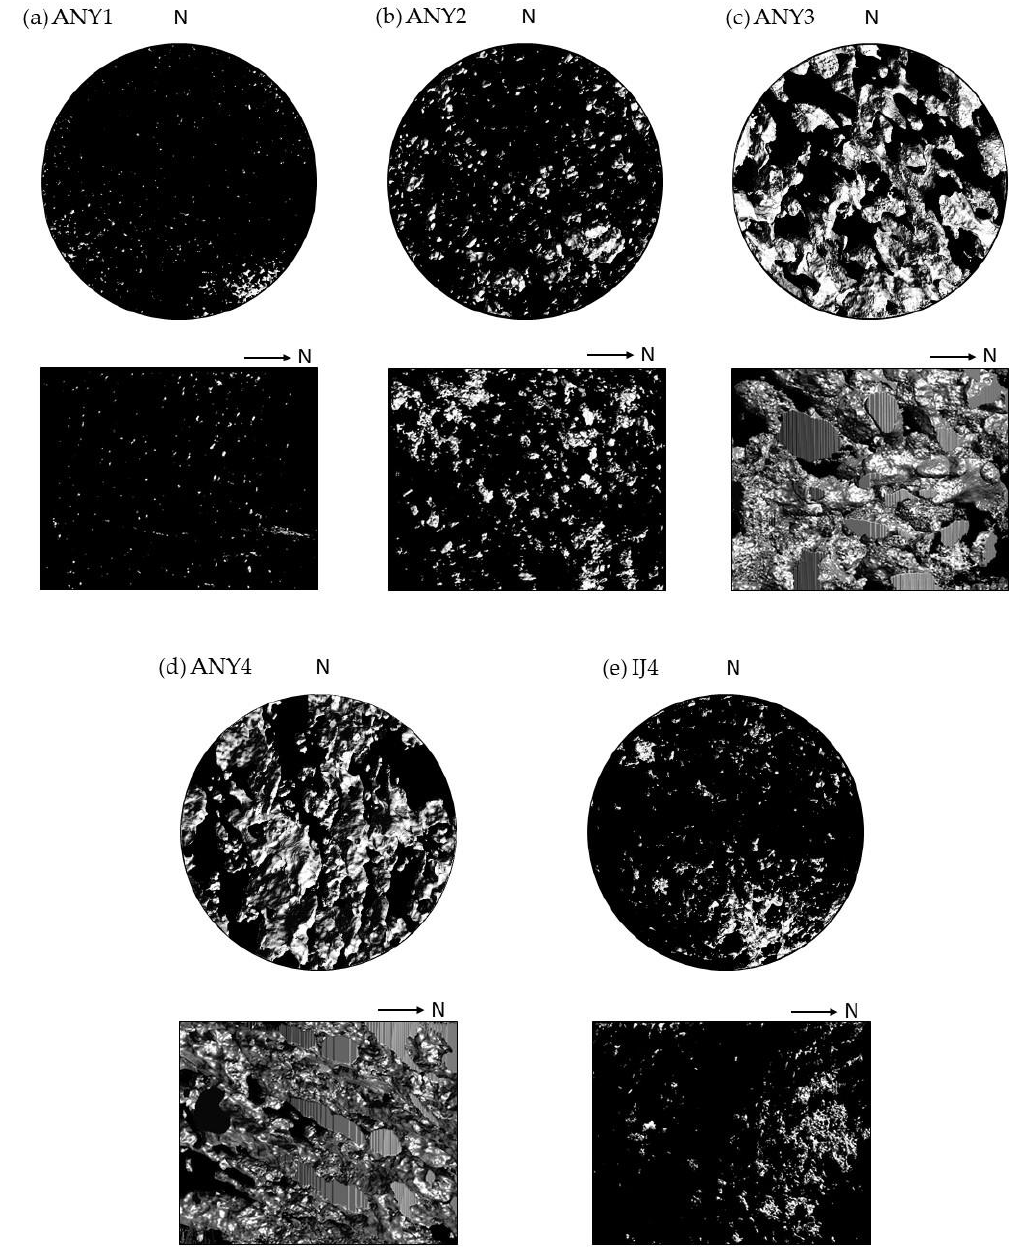
Figure 4. Pore distribution images of ( a ) ANY1; ( b ) ANY2; ( c ) ANY3; ( d ) ANY4 and ( e ) IJ4 seen from the top (circles) and side (rectangles) of the core specimens. Black hue represents the solid parts while greyish hue represents the pores. Round images are the vertical view of each sample while rectangular images represent the side view. N indicates north directions. Vertical streaks are from where the pores intersect the scan field. Darker images for ANY1 and IJ4 reflect their relatively low percentage of porosity and small pore space.